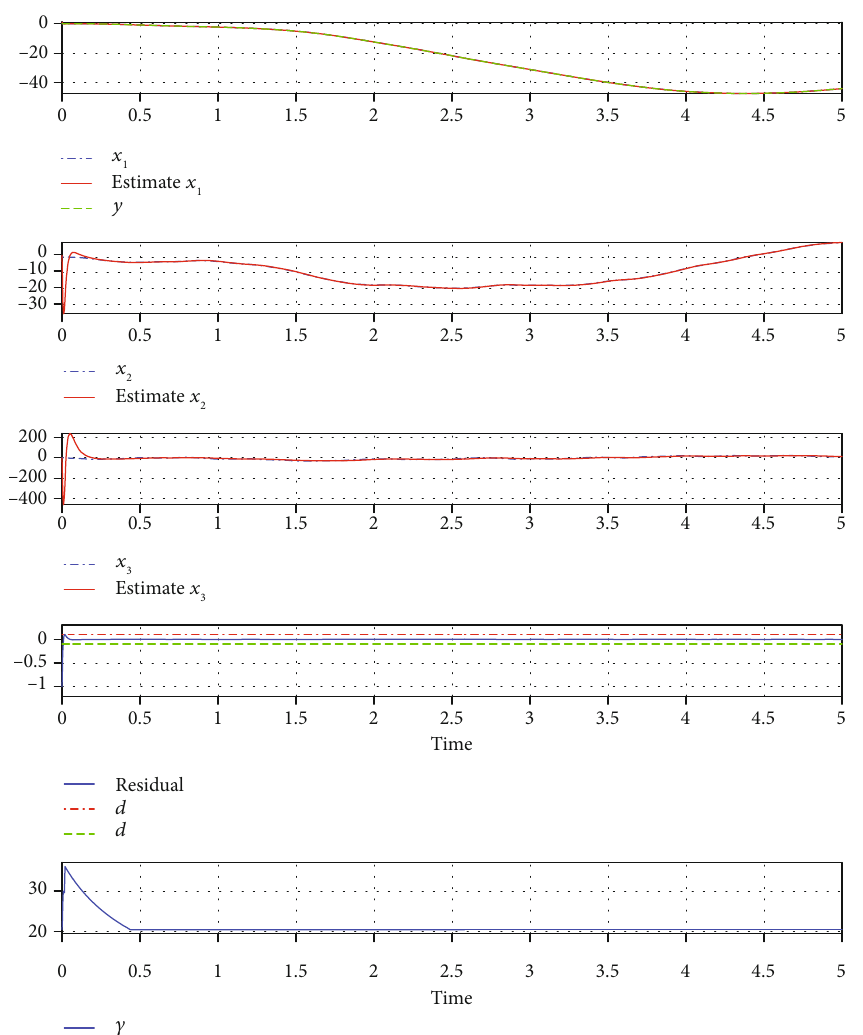
Figure 3: Measurement, state variables, estimates, residuals, and γ ð t Þ for x ð 0 Þ = ð 0,0,0 : 01 Þ and ̂ x ð 0 Þ = ð 1, 1, 1 Þ in a noisy simulation with ð t Þ = 0 and w ð t Þ zero-mean uniform random noise in w 1 2